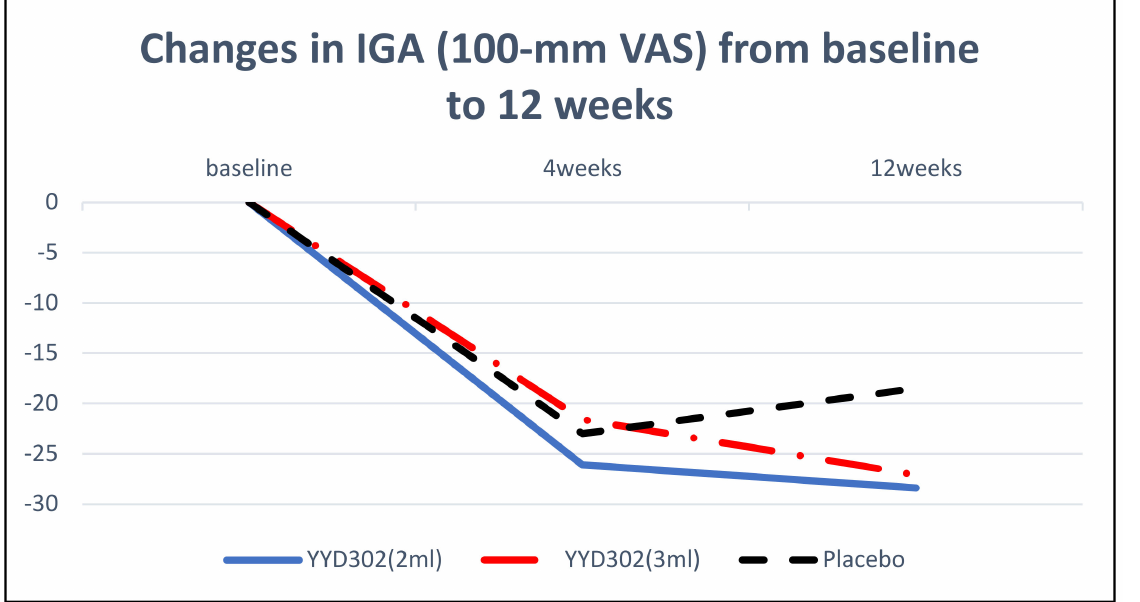
Figure 2. Changes in the Investigator Global Assessment (100-mm VAS) scores from the baseline to 12